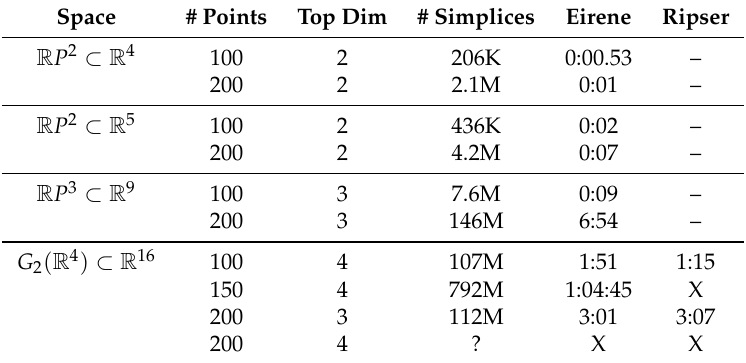
Table 1. Computation times on a MacBook Pro, 16 GB RAM, of Vietoris–Rips persistence for various spaces. An X indicates that the software could not complete the calculation; a indicates the software was not used for the run. The ? indicates the number of simplices is unknown. Note the rapid explosion in the number of simplices.